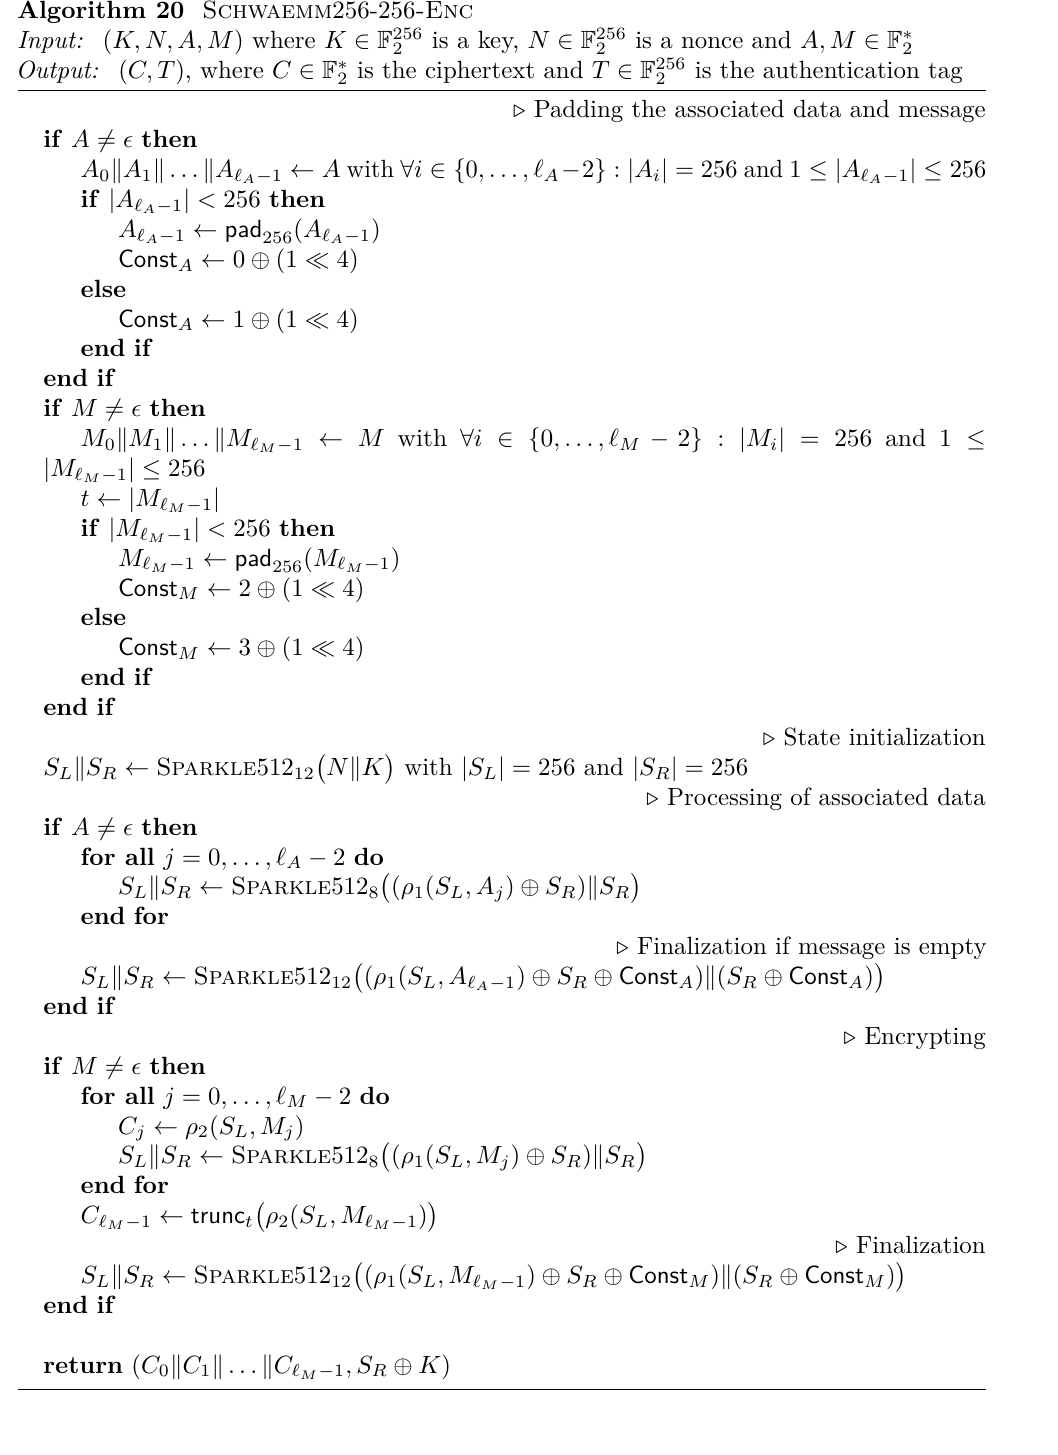
Algorithm 20 Schwaemm 256-256